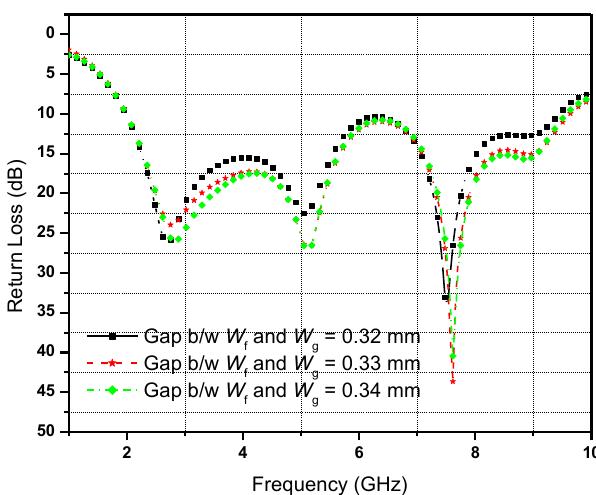
Figure 8: Simulated return loss against frequency for the octagonal ring shape ultra wideband antenna for the gap between ground plane and feed line: other parameters are the same as listed in Table 1.